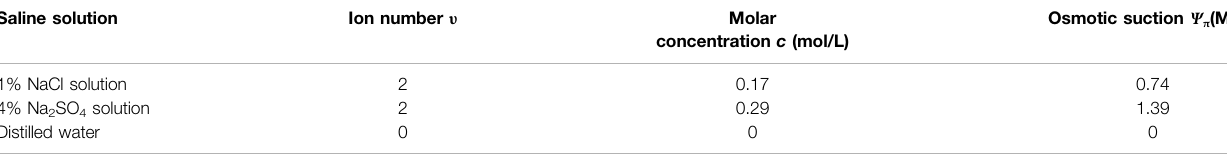
TABLE 3 | The osmotic suction of selected solution for soaking soil (15 °